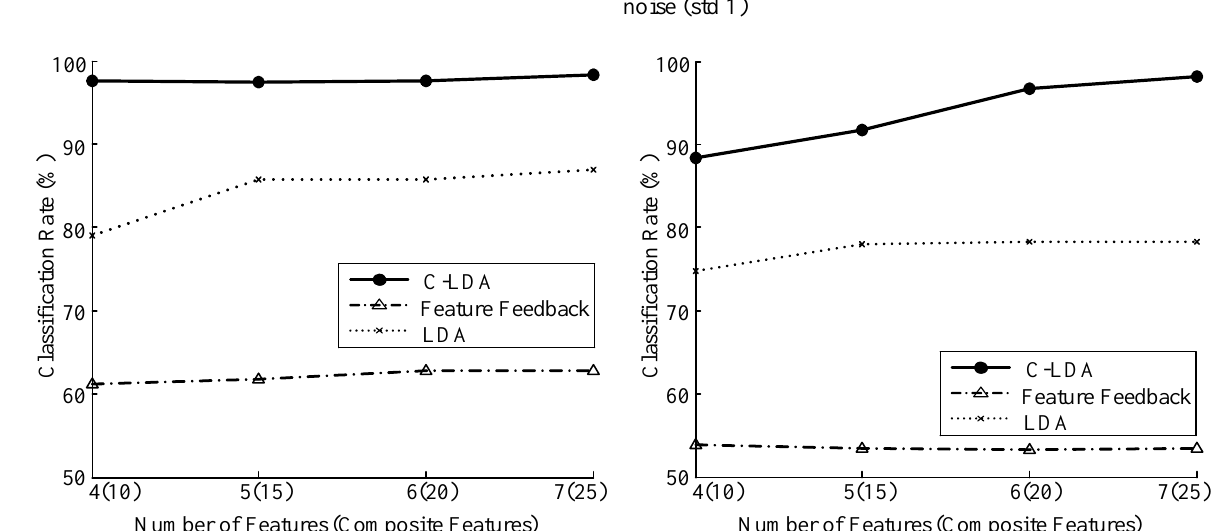
(d) Classification rates for the e-nose data with Gaussian noise (std